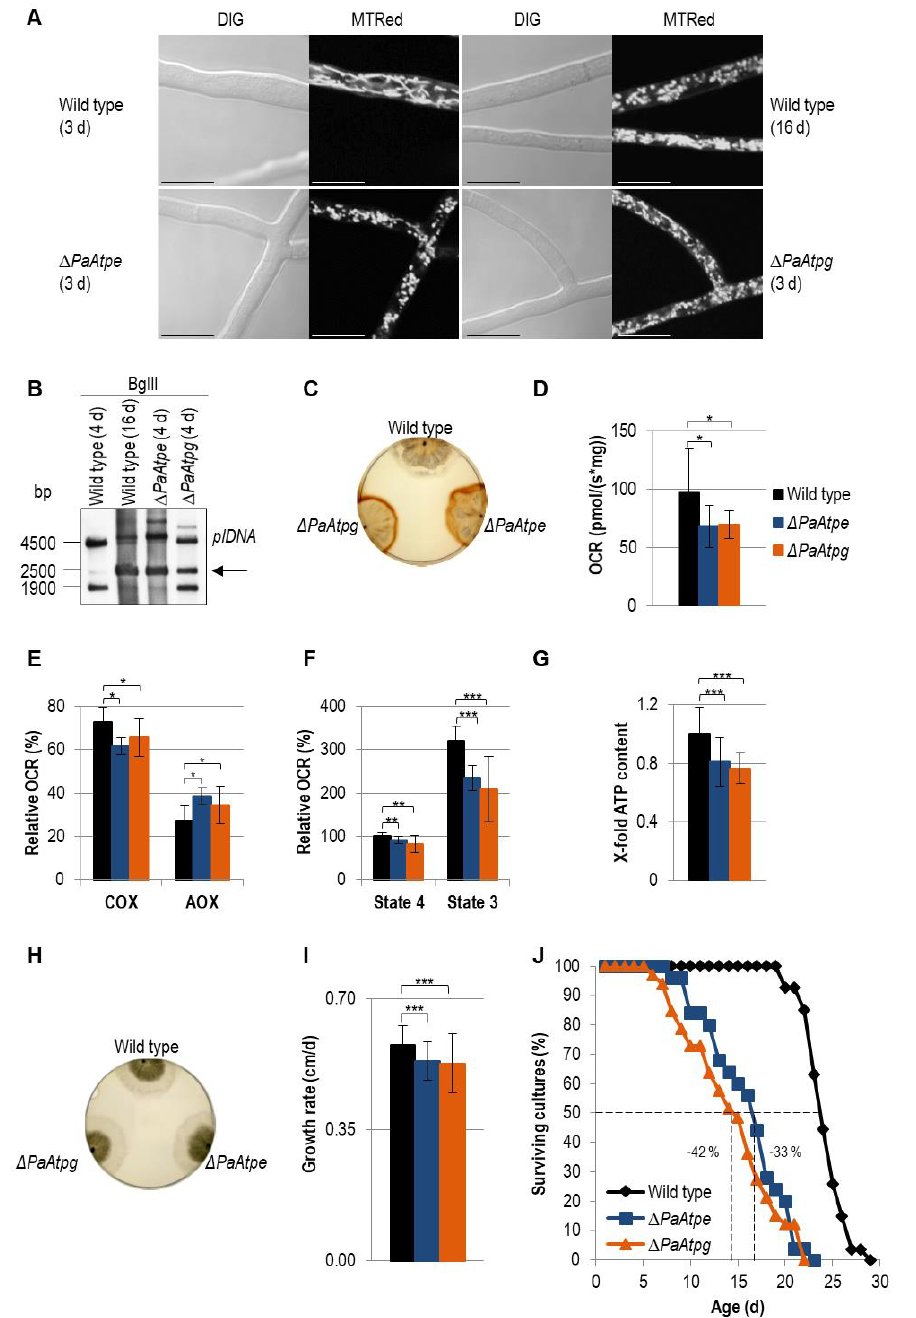
FIGURE 3: Impairments of mitochondrial functions affect growth and lifespan in deletion mutants. (A) Comparison of mitochondrial morphology of 3-days and 16-days old wild-type strains with those of ΔPaAtpe and ΔPaAtpg (3 d) by fluorescence microscopy. Mitochondria were stained with MitoTracker® Red and analyzed by confocal fluorescence microscopy. Scale bars: 10 µm. (B) Representative Southern blot analysis of BglII-digested gDNA of wild-type (4-days and 16-days old), ΔPaAtpe and ΔPaAtpg strains (4-days old). The 2500 bp age-specific plDNA (arrow) fragment was de- tected with a specific plDNA probe. (C) Release of ROS species H 2 O 2 from wild-type (6-days n=3), ΔPaAtpe (6-days n=3) and ΔPaAtpg strains (6-days n = 3) visualized by DAB precipitation. (D) Oxygen consumption (basal respiration) of 6-days old deletion mutant mycelium compared to respiration of 6-days old wild type mycelium (n = 3-4 biological replicates with a total number of 12-16 technical replicates). (E) Relative COX- and AOX-dependent oxygen consumption rate (OCR) of 6-days old wild-type and 6-days old deletion strains mycelium after treatment with KCN (COX-inhibitor) or SHAM (AOX-inhibitor). (F) Relative complex I-dependent OCR of 6-days old wild-type mitochondria compared to mitochondria from 6-days old deletion mutants (n = 4-8 biological replicates with a total number of 15-28 technical replicates). State 4 OCR of mitochondria from wild type was set to 100%. (G) ATP production of 6-days old wild-type and 6-days old deletion mutant mitochondria after removal of samples during state 3 respiration meas- urements. Samples of three biological replicates and two technical replicates, respectively, were measured three times by a luminescence-based assay. (H) Phenotypic analysis of indicated strains growing on M2 medium for 4 days. (I) Growth rate of wild type (0.58 ± 0.05 cm/d, n = 27), ΔPaAtpe (0.53 ± 0.05 cm/d, n = 25) and ΔPaAtpg (0.53 ± 0.08 cm/d, n =3 3) growing on M2 medium. Growth rate was determined from day 3 to 6 of growth. (J) Lifespan analysis of wild type (mean lifespan = 23.3 d, n = 27), ΔPaATPe (mean lifespan = 15.1 d, n = 25,) and ΔPaATPg (mean lifespan = 13.5 d, n = 33) growing on M2 medium. The error bars represent the standard deviation and the P-values were determined by Student´s t